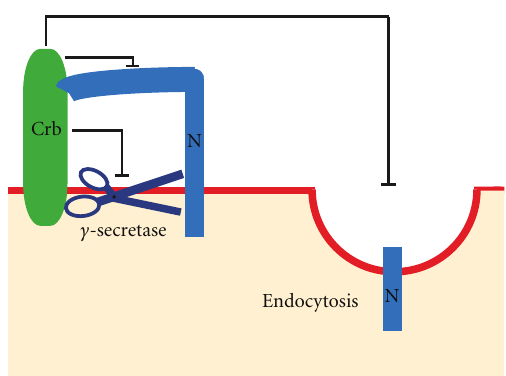
Figure 3: Crb proteins control Notch-dependent tissue growth. Crb proteins repress Notch (N) signaling in Drosophila , zebra fish, and mammalian cells. Di ff erent mechanisms account for the Crb-dependent inhibition of Notch signaling. Drosophila Crb and CRB2 inhibit γ -secretase activity. In addition, Crb limits Notch endocytosis, which is important for Notch signaling. Finally, the extracellular domain of Crb proteins binds to Notch and counteracts its